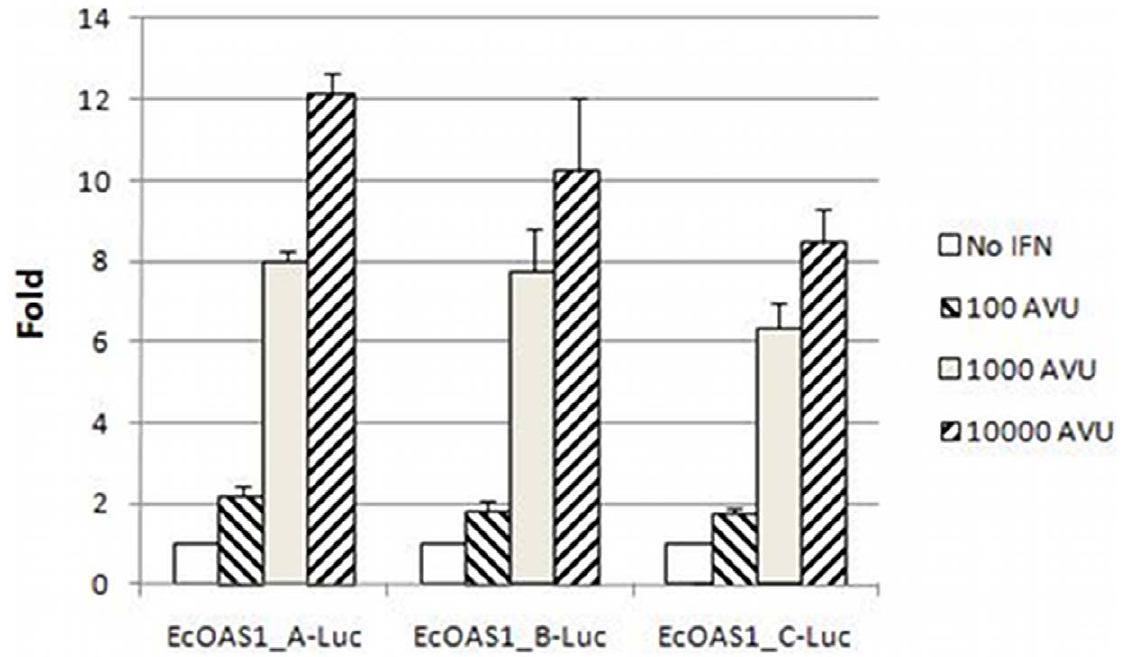
Figure 2. Effect of IFN dose on OAS1 -luciferase activity in 2fTGH fibroblast cells. Cells were transfected with full-length clones and treated with 10 2 , 10 3 or 10 4 AVU IFN. Reporter activity was measured 24 hours after treatment in triplicate. All constructs showed a dose-response to IFN. Statistically significant differences in IFN response occurred when cells were treated with 10,000 AVU IFN (ANOVA, p=0.026). Pair-wise comparison of EcOAS1_A-Luc and EcOAS1_C-Luc fold induction was statistically significant after Bonferroni correction (p=0.0275).